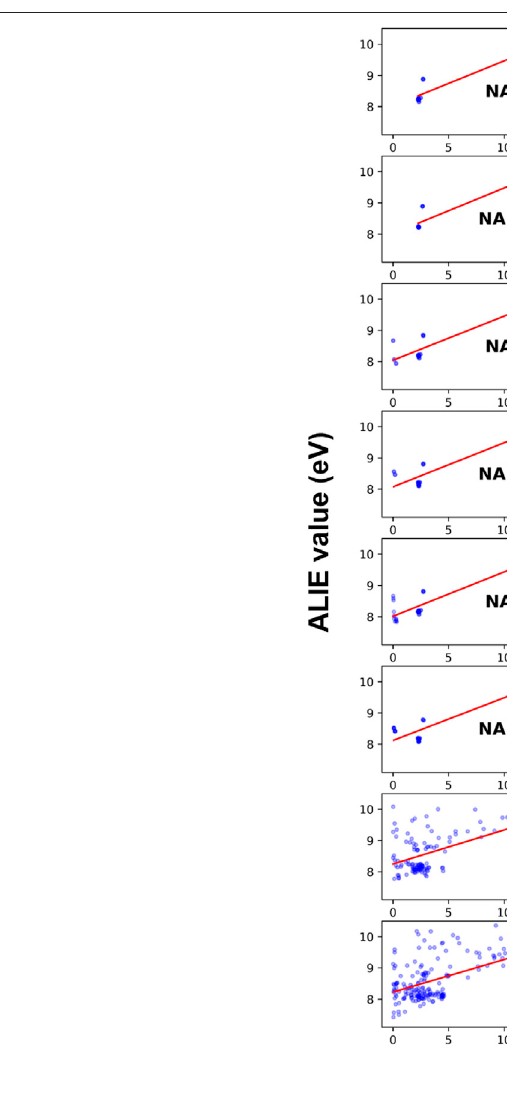
Frontiers in Mechanical Engineering |